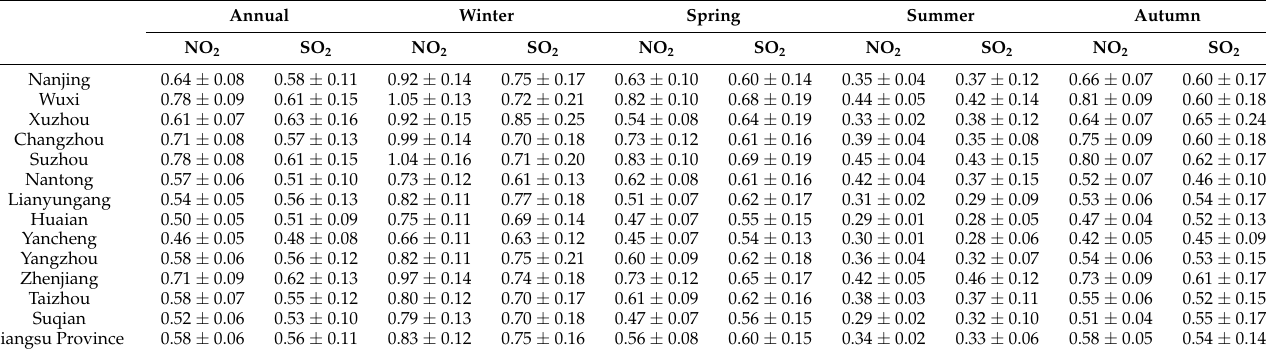
Table 1. The city-averaged seasonal and annual mean NO 2 and SO 2 ( ± STD) (DU) obtained from OMI from 2005 to 2020 in 13 cities of Jiangsu Province.